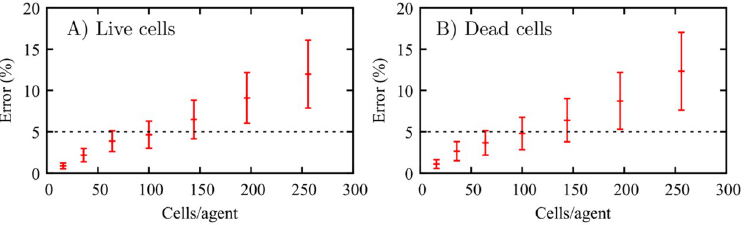
Fig 4. Effects of the coarse-graining on the ABM. Mean relative absolute error between the ABM and the cgABM, and its 95% credible interval (which is the Bayesian equivalent of the confidence interval), of live (A) and dead (B) cells. The simulations are executed for 16, 36, 64, 100, 144, 196, and 256 cells/agent. The horizontal dashed line indicates our 5% tolerance for the mean relative absolute error indicating that 100 cells/agent is the appropriate scenario for all subsequent analyses. The mean error and 95% credible interval between the coarse-grained model and the ABM, for the 100 cells/agent scenario, are 4.64 ± 1.64% and 4.80 ± 1.96% for live and dead cells,